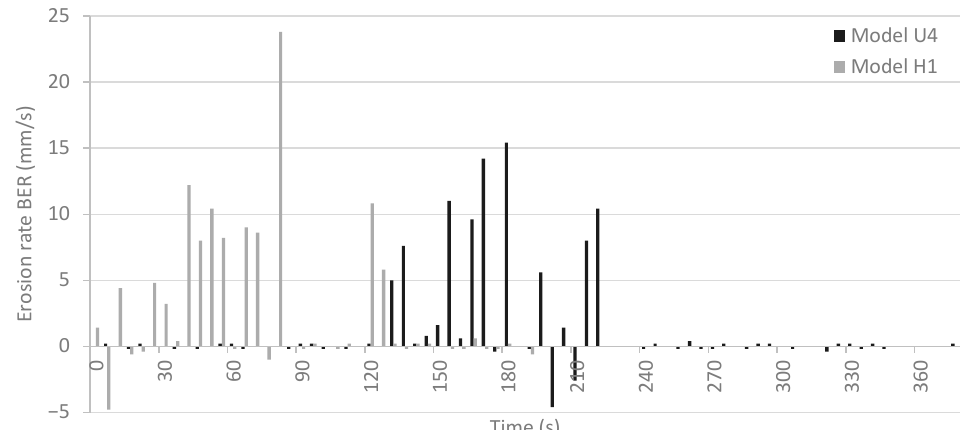
Figure 16. Lateral erosion rates (BER) over 5 s time steps (mm/s) at X = 0 m for tests U4 (central core) and H1 (no core).